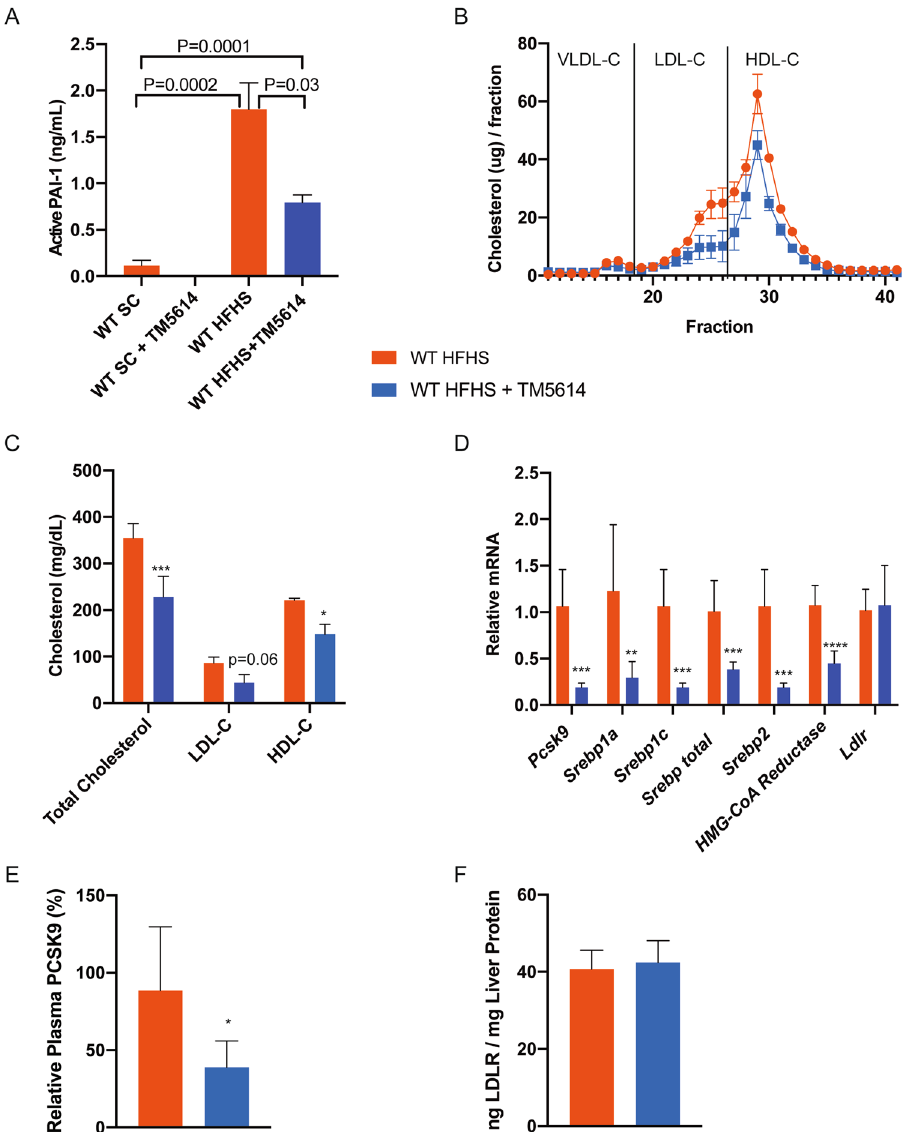
Figure 3. Long-term TM5614 treatment leads to a reduction in circulatory cholesterol and PCSK9 in mice fed a HFHS diet. WT C57BL/6 J male mice fed HFHS diet with and without TM5614. ( A ) Active PAI-1 levels (ng/mL). ( B ) Cholesterol distribution on plasma lipoprotein fractions resolved by FPLC from pooled samples (n = 2 for HFHS, n = 3 for HFHS + TM5614) (2-way ANOVA p = 0.03). ( C ) Quantification of cholesterol in each lipoprotein fraction calculated using area under the curve from the FPLC profile. ( D ) Hepatic mRNA expression of cholesterol regulatory pathway nodes. ( E ) Plasma PCSK9 levels (ng/mL). ( F ) LDLR protein levels from liver lysates (ng LDLR/mg Liver Protein). Values are express as mean ± SEM (n = 7), * p < 0.05, ** p < 0.01, *** p <